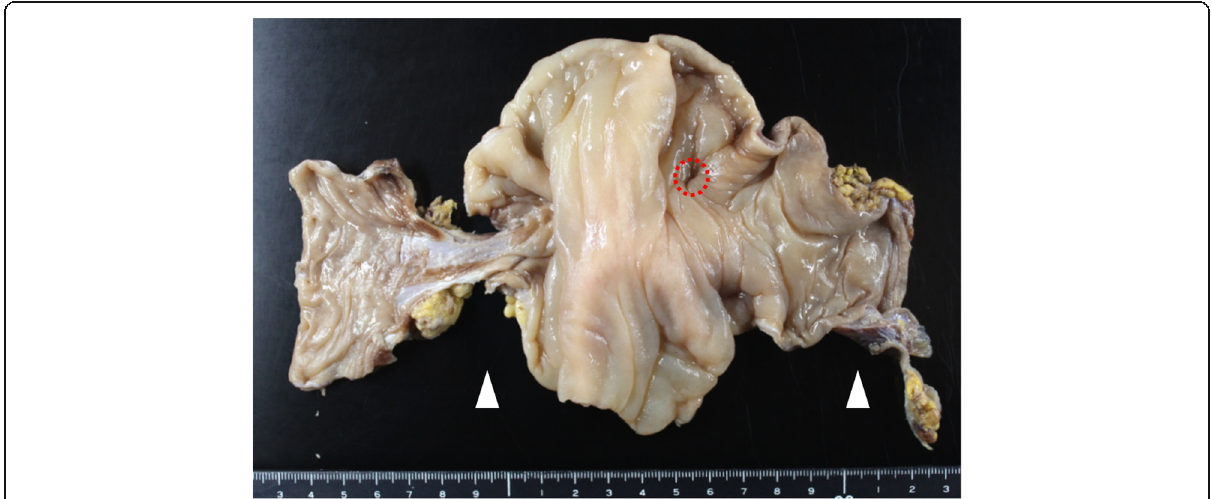
Fig. 3 Macroscopic view of the resected specimen showing perforation of the colon (red circle) and the edematous colonic wall without necrosis between the constrictions (arrow